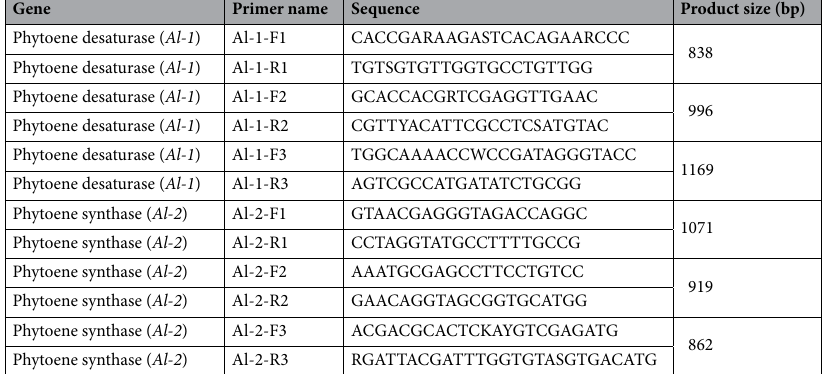
motifs 50 . Based on these alignments, putative ORFs were annotated and aligned, and an overlapping set of PCR primers for AL-1 and AL-2 were designed in Geneious (Table 5). Designed primers were tested for specificity using the BLAST algorithm against the three Cantharellus genomes 18 . PCR amplified products were assessed for quality, cleaned, sent for sequencing, and assembled as above. Assembled sequences of white and gold samples were compared, along with their putative amino acid products determined using ExPASy 51 , guided by the trans- lations of the Neurospora crassa Al-1 (XM_959620.2) and Al-2 (XM_960632.3) genes. Partial sequences of the Al-1 and Al-2 genes of gold and white variants have been deposited in GenBank as MW442833–MW442836. Pigment analysis. Field-collected mushroom fruiting bodies were weighed while fresh, wrapped in alu- minum foil, and frozen at − 80 °C for pigment analyses, and other samples were weighed fresh and then dried to obtain a conversion for fresh to dry weight. Pigments were extracted with ice-cold 100% acetone at 4 °C and dim light. The supernatant was filtered through a 0.22 µm syringe filter and samples were stored at − 80 °C until analysed. Pigments were separated and quantified by high-performance liquid chromatography (HPLC) as described previously 20 , with some modifications. The system consisted of a Beckman System Gold program- mable solvent module 126, diode array detector module 168 (Beckman Instruments, San Ramon, California, USA), CSC-Spherisorb ODS-1 reverse-phase column (5 mm particle size, 25 × 0.46 cm I.D.) with an Upchurch Perisorb A guard column (both columns from Chromatographic Specialties Inc., Concord, Ontario, Canada). Samples were injected using a Beckman 210A sample injection valve with a 20 μL sample loop. Pigments were eluted isocratically for 6 min with a solvent system of acetonitrile:methanol:0.1 M Tris–HCl (pH 8.0), (72:8:3.5, v/v/v), followed by a 2 min linear gradient to 100% methanol:hexane (75:25, v/v) which continued isocratically for 4 min. Total run time was 12 min. Flow rate was 2 mL min −1 . Absorbance was detected at 440 nm and peak areas were integrated by Beckman System Gold software. Retention times and response factors of Chl a , Chl b , lutein and ß-carotene were determined by injection of known amounts of pure standards purchased from Sigma (St. Louis, MO, USA). The retention times of zeaxanthin, antheraxanthin, violaxanthin and neoxanthin were determined by using pigments purified by thin-layer chromatography as described by Diaz et al. 52 . Extraction and analysis of chanterelle lipids. Samples of each chanterelle species were homogenized to fine powder in a cryomill (Reitch, Germany) and 100 mg of the homogenized powder mixed with 1 mL methanol (MeOH), 1 mL chloroform (CHCl 3 ) and 0.8 mL water following Pham et al. 53 . The sample mixture was thoroughly vortexed, then centrifuged (Sorvall Legend XT/XF centrifuge; ThermoFisher Scientific, Missis- sauga, Ontario) at 2500 rpm for 15 min. The organic layer was transferred to new vials, dried under nitrogen and then reconstituted in 1 mL chloroform:methanol (1:1 v/v). Aliquots were then used for either gas chromatog- raphy with mass spectrometric and flame ionization detection (GC–MS/FID) or ultra-high-performance liquid chromatography with heated electrospray ionization high resolution accurate mass tandem mass spectrometric analysis (UHPLC-HESI-HRAM/MS–MS) for fatty acids and intact lipids analysis, respectively. For GC–MS/FID analysis, chanterelle fatty acids were converted to fatty acid methyl esters (FAMEs) as fol- lows: To 300 µL aliquot of the lipid extract, 50 μL of C18:0 alkane (1 mg mL −1 in chloroform: methanol 1:1 v/v) was added as internal standards and the samples dried under nitrogen and the fatty acids esterified by adding 400 µL methanolic HCl (1.5 N). The samples were then incubated in a pre-heated oven at 60 °C for 30 min. After incubation, 0.8 mL of distilled water was added to the cooled samples and the FAMEs extracted with 3 aliquots each of 500 μL of hexane. The fractions were combined, dried under N 2 , re-suspended in 50 μL hexane, and the FAMEs analyzed using a Trace 1300 gas chromatograph coupled to a Flame Ionization Detector and TSQ 8000 mass spectrometer (Thermo Fisher Scientific). The FAMEs were separated on a BPX70 high-resolution column